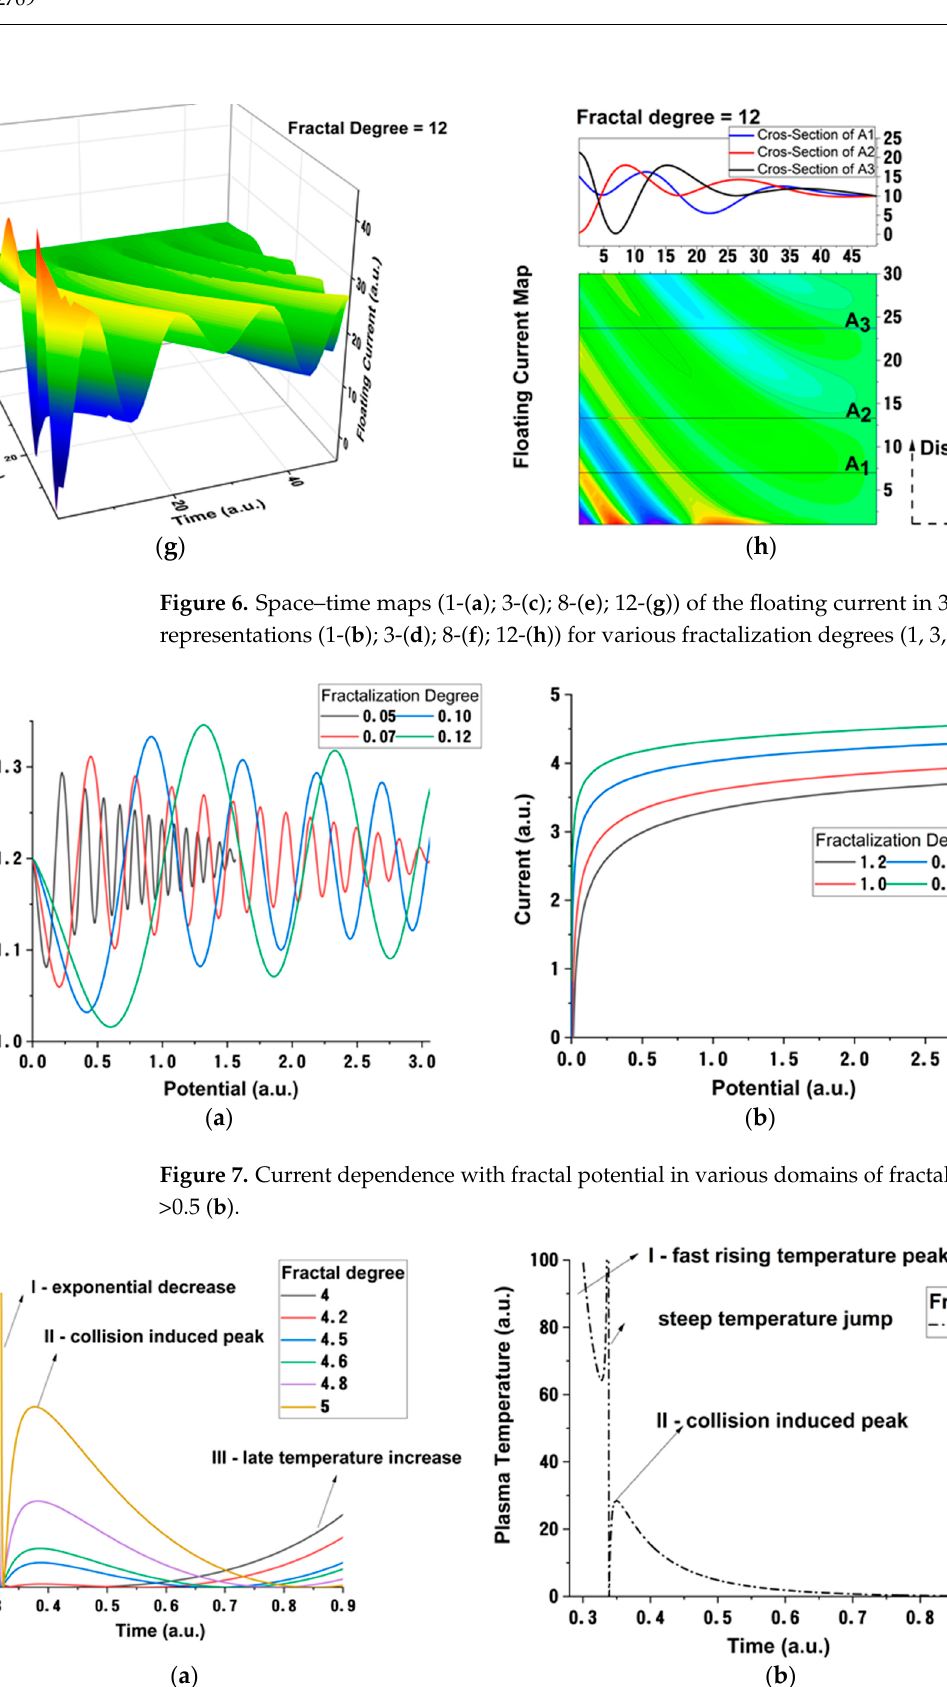
Figure 6. Space–time maps (1-( a ); 3-( c ); 8-( e ); 12-( g )) of the floating current in 3D and contour plot representations (1-( b ); 3-( d ); 8-( f ); 12-( h )) for various fractalization degrees (1, 3, 8, 12).